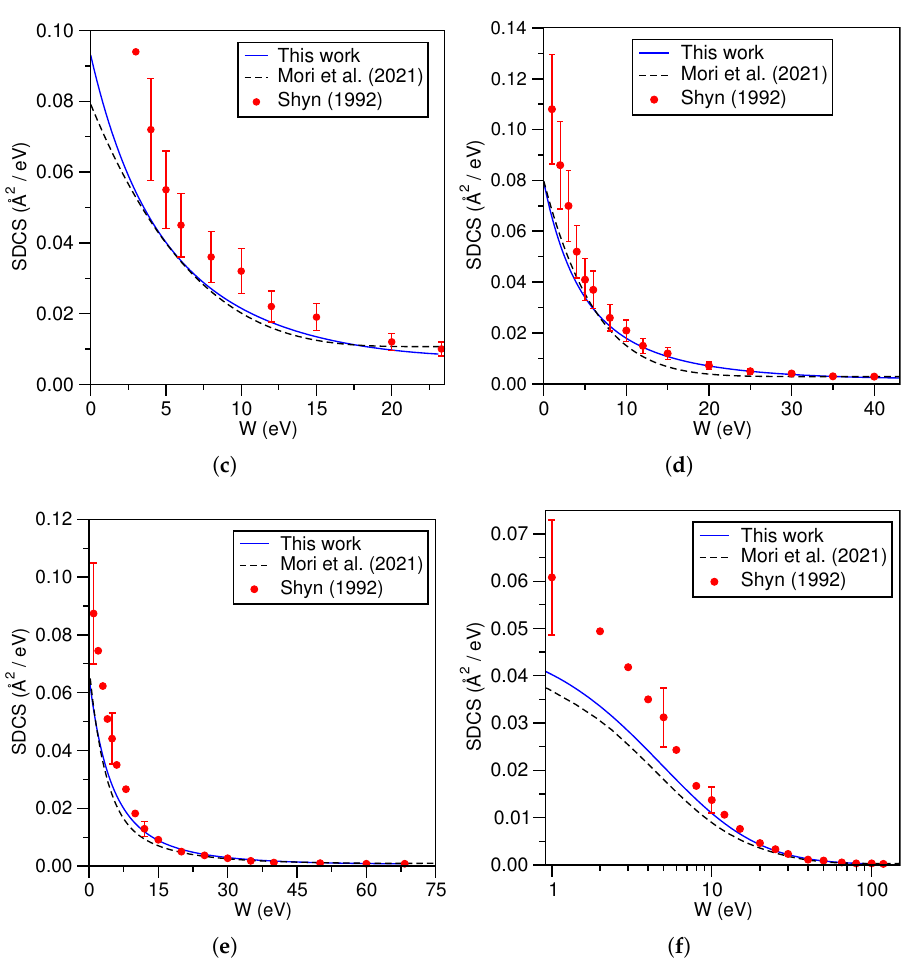
Figure 1. Electron-impact SDCS for H-atom at different primary electron energies ( a ) T = 25 eV, ( b ) T = 40 eV, ( c ) T = 60 eV, ( d ) T = 100 eV, ( e ) T = 150 eV, and ( f ) T = 250 eV. The present results are represented by solid lines, the dashed lines represent the results of Mori et al. [33], and the filled circles represent the experimental measurements of Shyn